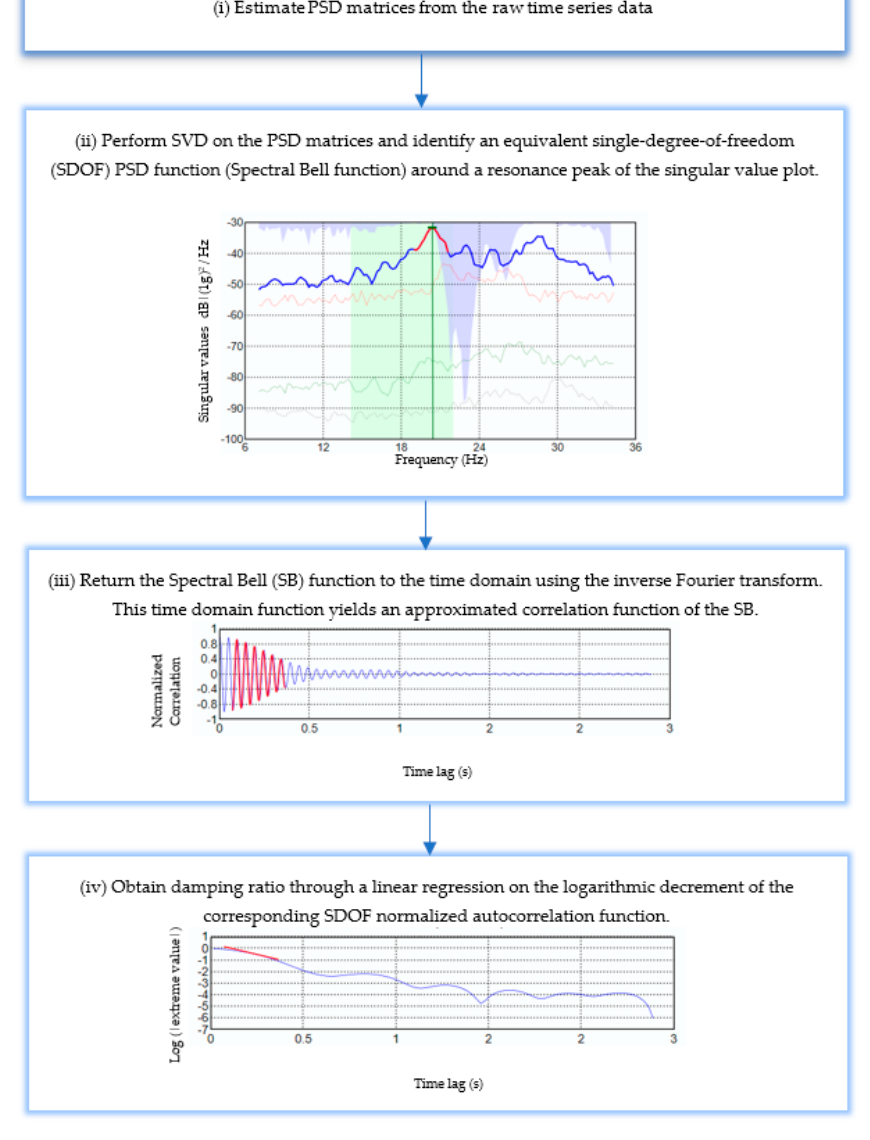
Figure 8. Logical diagram of damping ratio estimation based on the Enhanced Frequency Domain Decomposition (EFDD) method. Extracted from ARTeMIS Modal Pro [21].